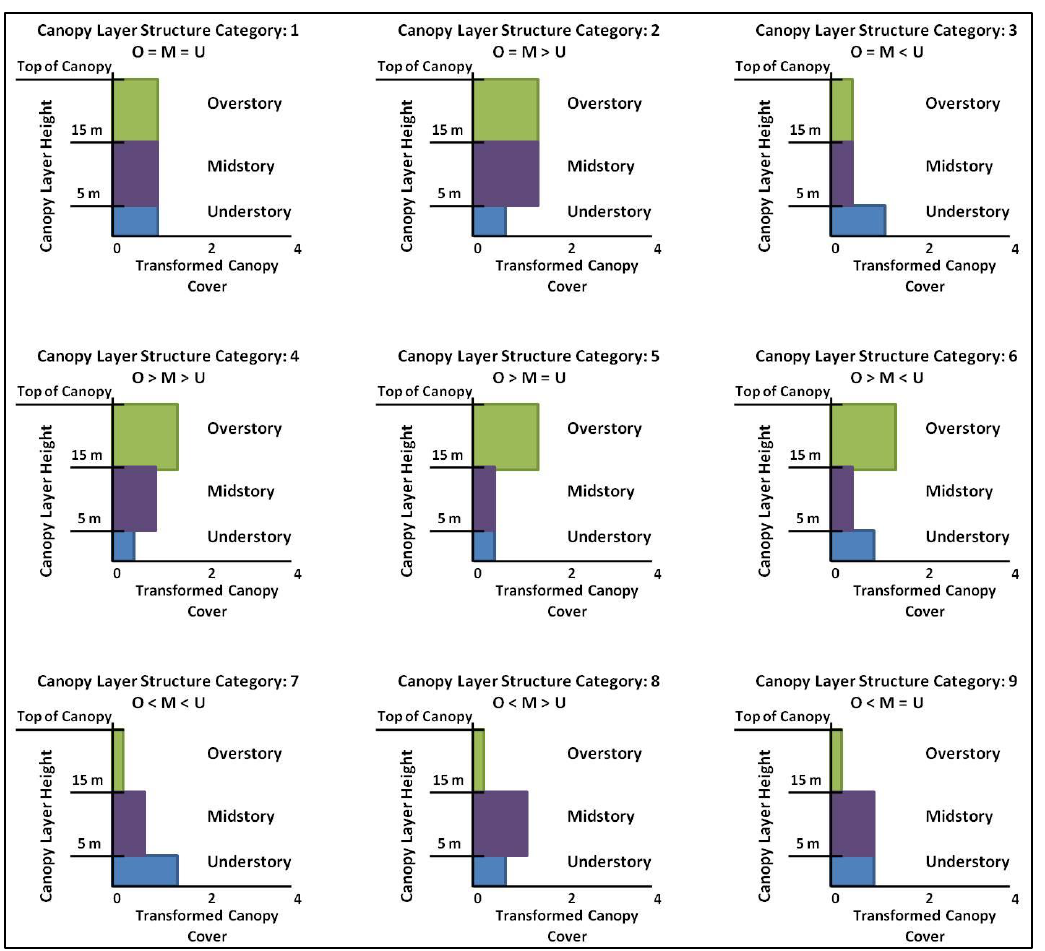
Figure 3. Illustrations of the canopy layer structure